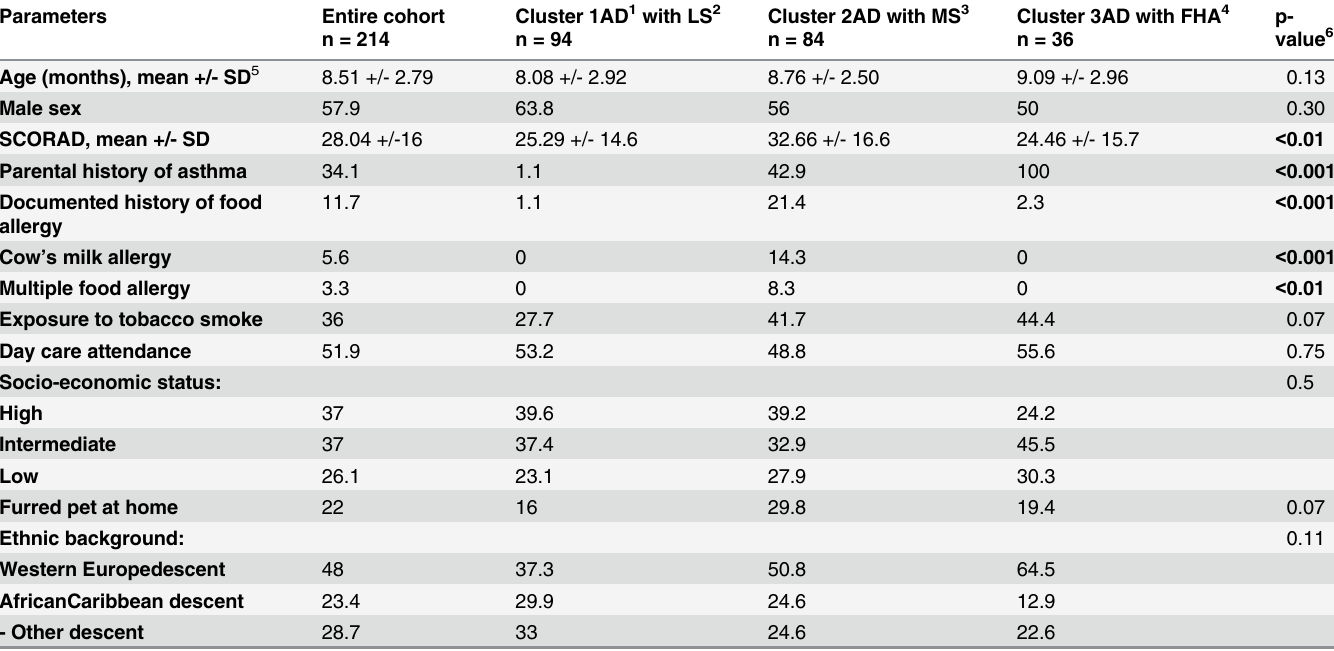
Table 1. Clinical parameters at inclusion in the entire cohort and according to cluster analysis.